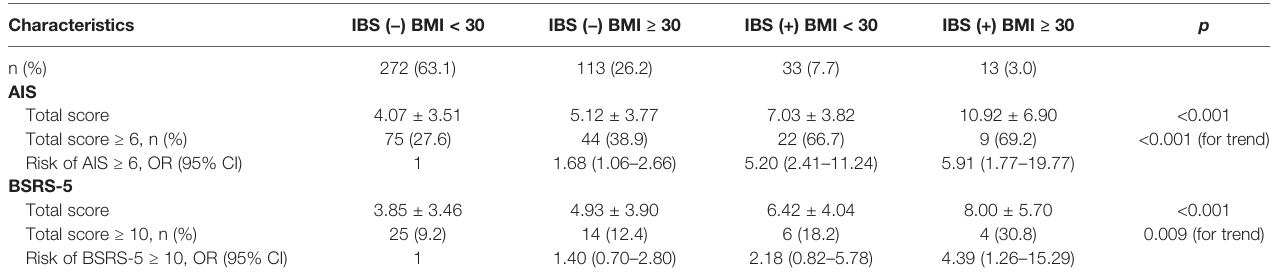
TABLE 5 | Sleep and psychological characteristics of patients with PCOS strati fi ed according to presence of IBS and obesity (BMI ≥ 30 kg/m 2 ).